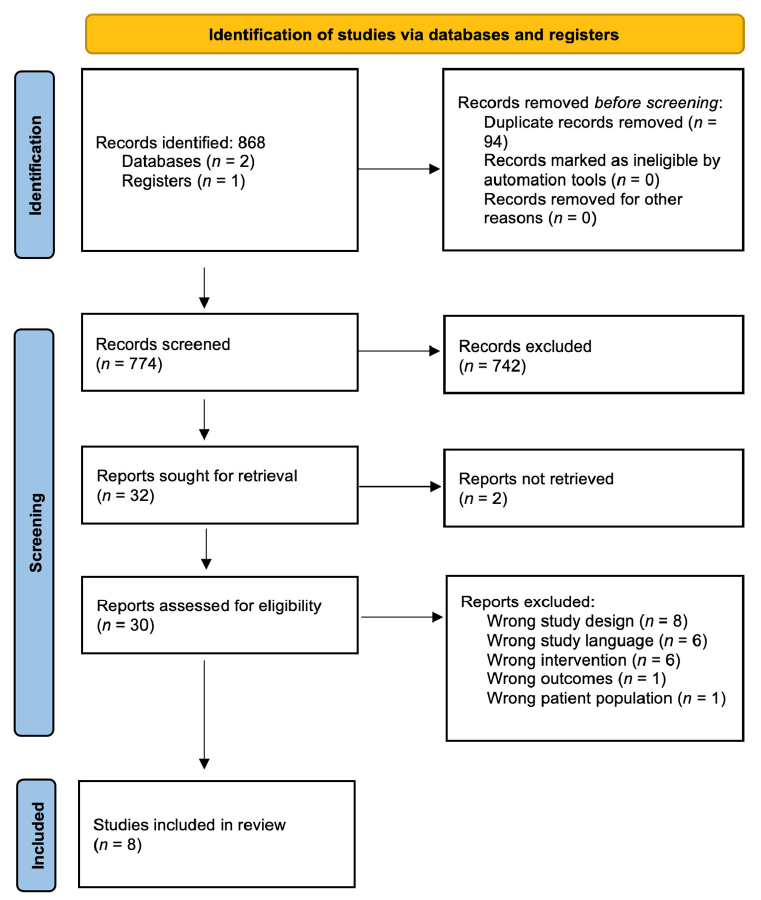
Figure 1. Systematic Reviews and Meta-analysis (PRISMA) guidelines flow diagram.